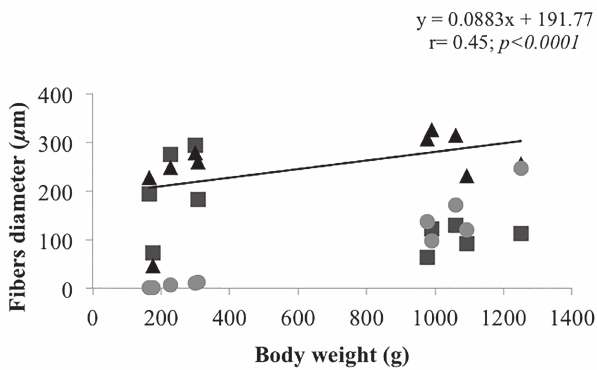
Fig. 5. Correlation between the fibers diameters and body weight from 300 days old Colossoma macropomum . The fibers diameters are showed by class: circle (<20 µ m), triangle (20 to 50 µ m) and square (>50 µ